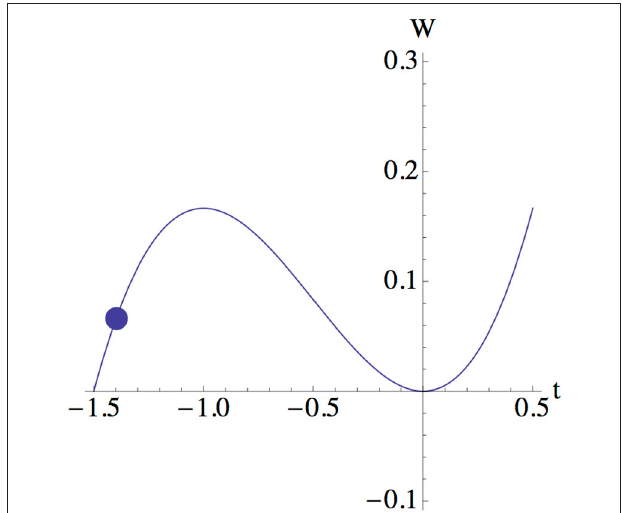
FIGURE 2 | Solution at g = 1.0.